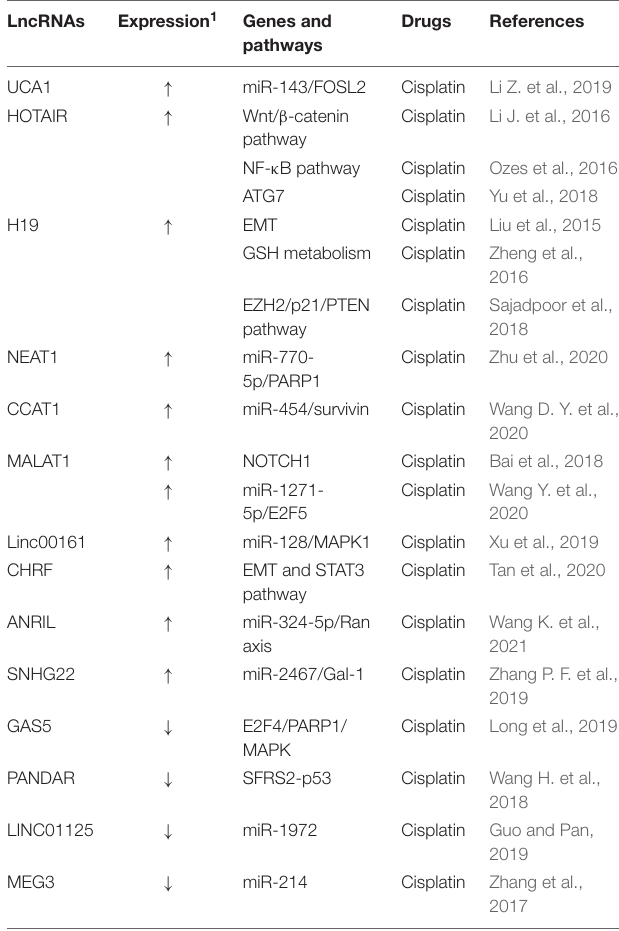
TABLE 4 | LncRNAs and platinum resistance in ovarian